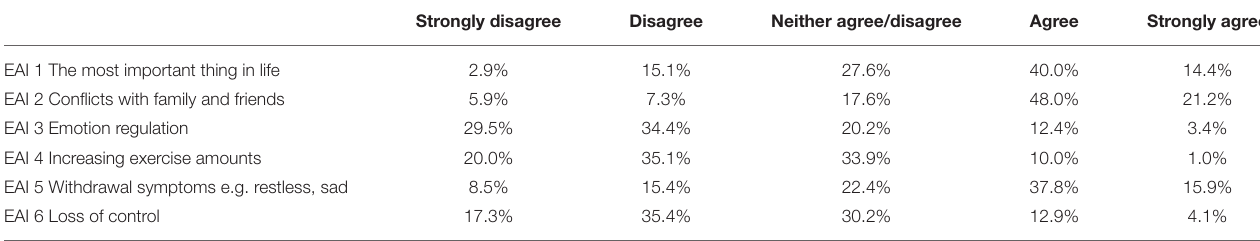
TABLE 1 | Distribution of scores on the Exercise Addiction Inventory (EAI).